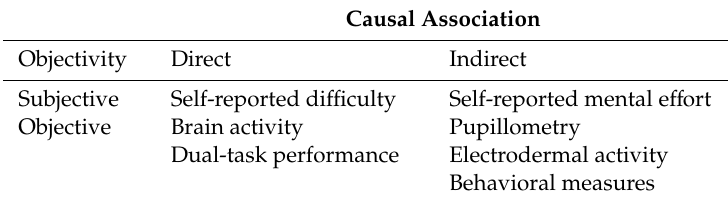
Table 1. Classification of approaches to measuring cognitive load with